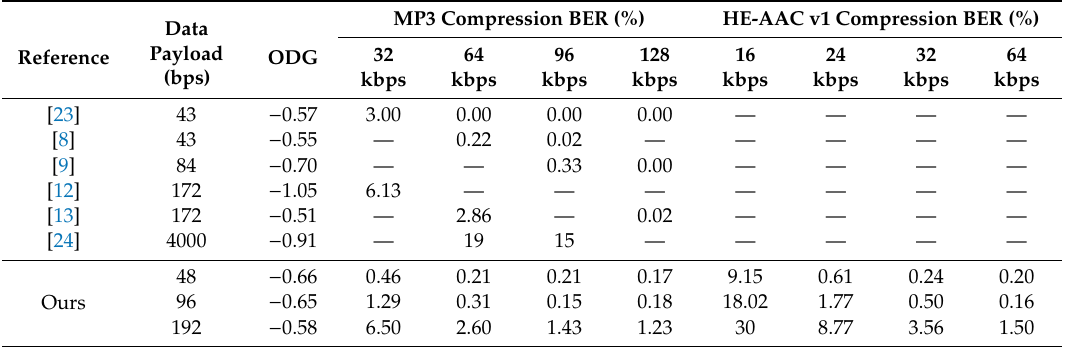
Table 6. Performance comparison results with state-of-the-art algorithms under MP3 compression, sorted by data payload. (“—” means not